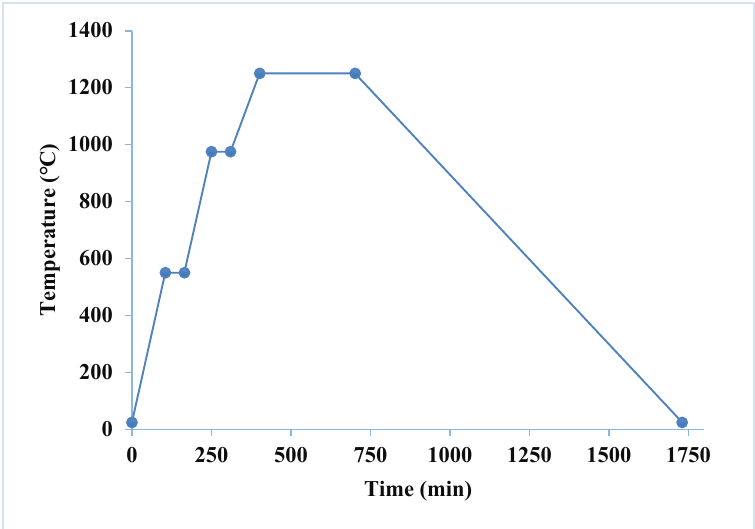
Figure 2. Sintering procedure of microfiltration membranes .